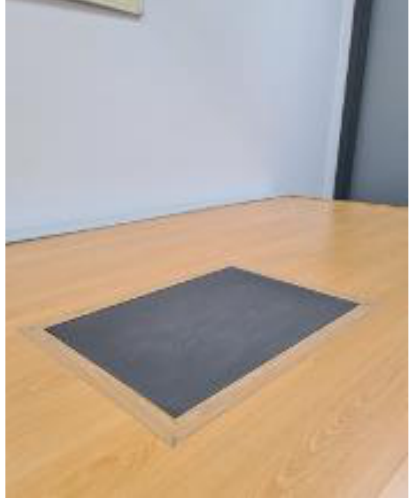
Figure 2. Force platform FP4060-07, Bertec Columbus, OH, USA.